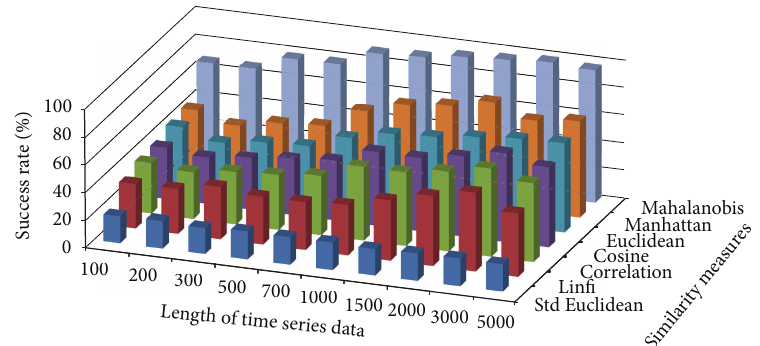
Figure 10: Average success rate of pattern recognition using DFT-based feature extraction in first scenario.